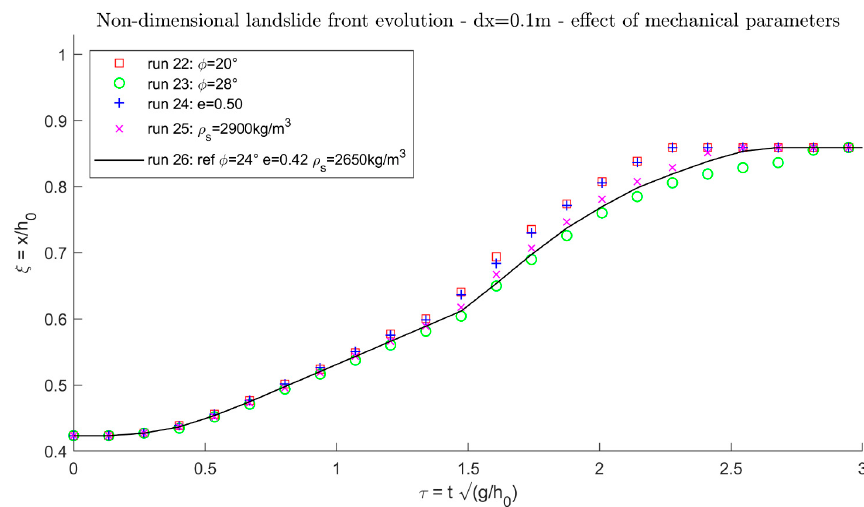
Figure 6. Effects of geotechnical parameters variation on landslide front propagation. Figure 6. E ff ects of geotechnical parameters variation on landslide front propagation. Non-dimensional Non-dimensional front position ξ as function of non-dimensional time τ . front position ξ as function of non-dimensional time τ